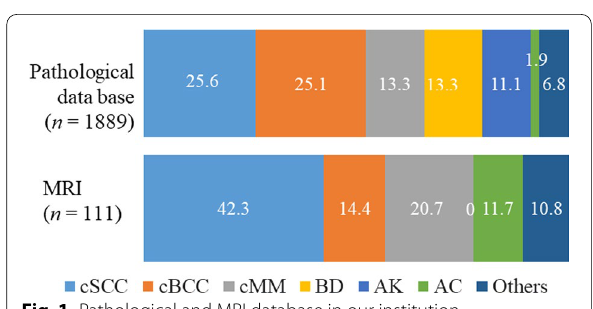
Fig. 1 Pathological and MRI database in our institution. SCC squamous cell carcinoma, BCC = MM malignant melanoma, BD = keratosis, AC appendageal =